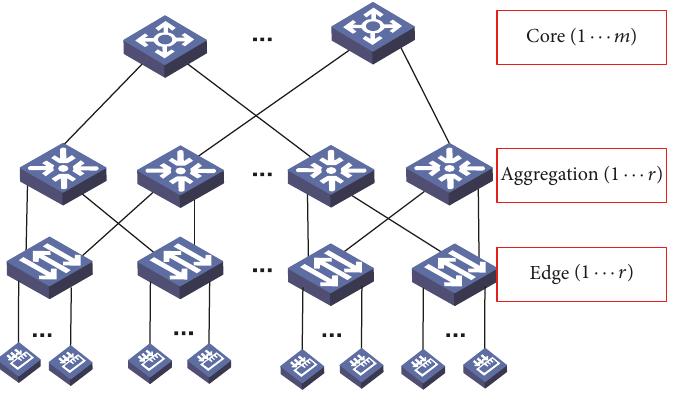
Figure 2: The topology of fat-tree DCNs.